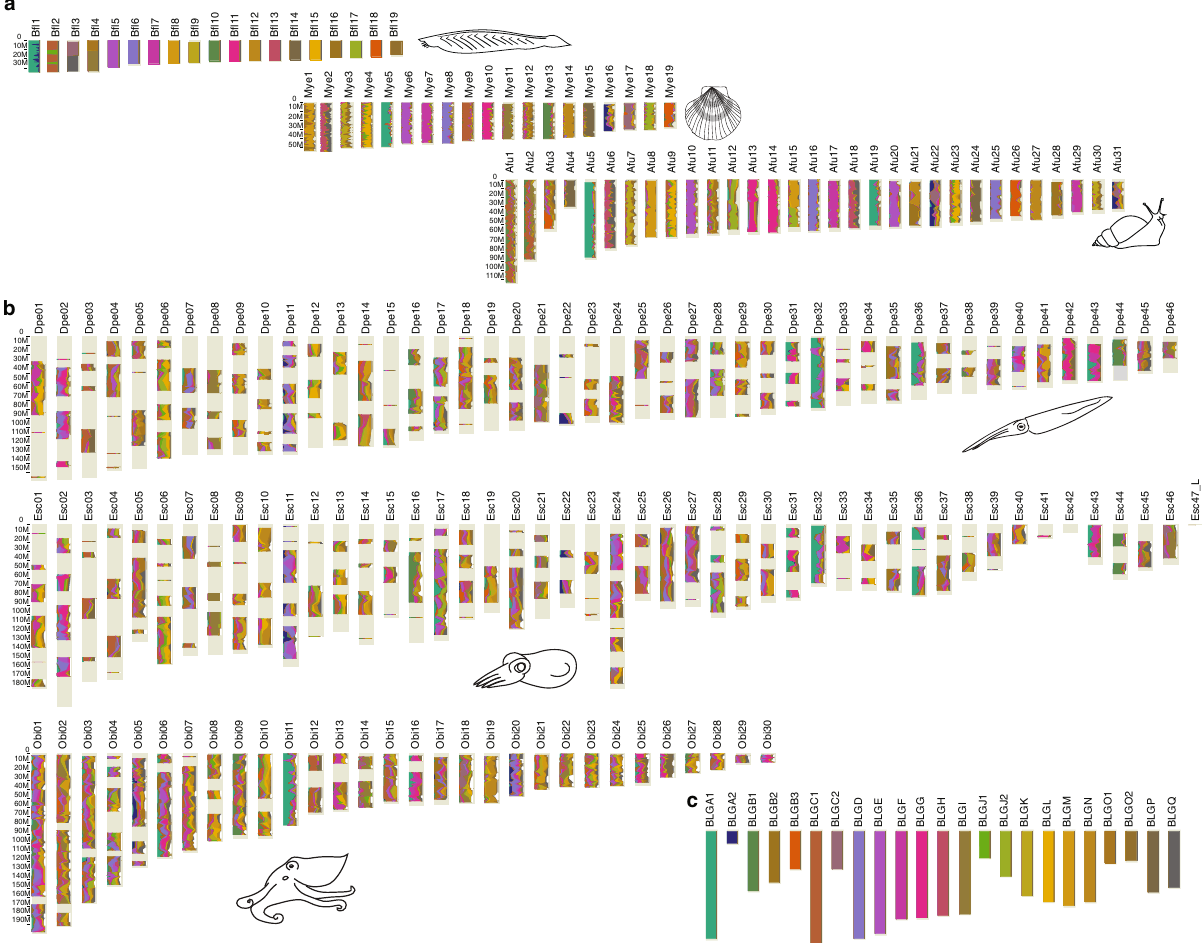
Fig. 3 Bilaterian linkage group (BLG) orthologs on amphioxus, scallop, snail, and cephalopod chromosomes. a Top: Amphioxus ( B. fl oridae ) chromosomes correspond 1:1 to BLGs with some exceptions: B fl 1 — chordate fusion of BLGA1 and A2; B fl 2 — recent amphioxus fusion of BLGC1 and BLGJ1; B fl 3 — recent amphioxus fusion of BLGC2 and BLGQ; B fl 4 — recent amphioxus fusion of BLGO1 and BLGI. Middle: M. yessoensis chromosomes show some mixing of BLGs, but most chromosomes primarily correspond to one BLG. Bottom: A. fulica chromosomes follow similar patterns as M. yessoensis chromosomes, except that A. fulica underwent a whole genome duplication 94 resulting in several duplicate chromosomes. b BLG orthologues on cephalopod chromosomes show extensive mixing of multiple BLGs throughout. Top: D. pealeii chromosomes. Middle: E. scolopes chromosomes. Bottom: O. bimaculoides chromosomes. c BLG color